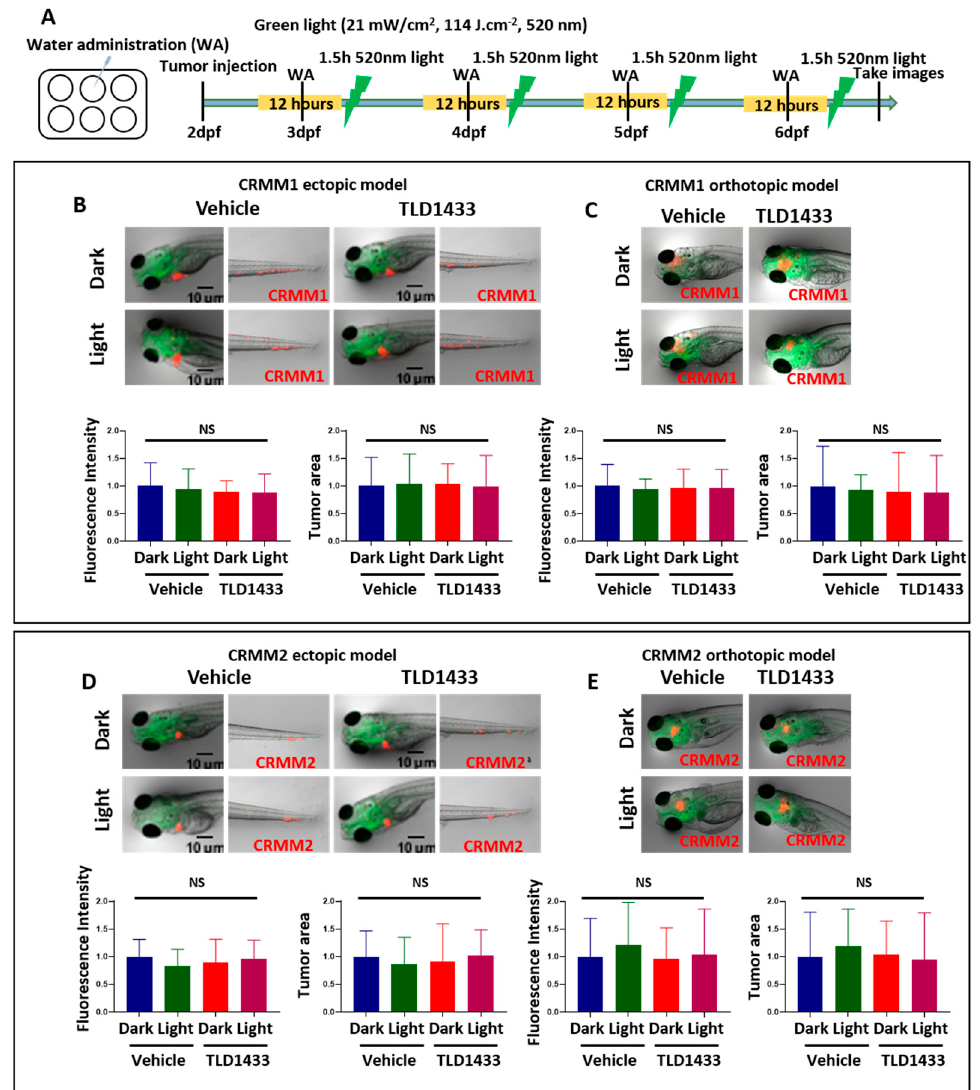
Figure 7. Treatment of zebrafish ectopic and orthotopic CM models with TLD1433 through WA. ( A ) Schedule of tumour injection and TLD1433 administration in zebrafish embryos. Fluorescent CRMM1 and CRMM2 cells were injected at 2 dpf into the Duct of Cuvier (ectopic model) and behind the eye (orthotopic model) and TLD1433 was administered with or without a light treatment following the schedule presented in A. Relative tumour burden estimated as fluorescence intensity and tumour area was calculated by Image J. ( B ) CRMM1 tumour burden in ectopic model ( n ≈ 30). ( C ) CRMM1 tumour burden in orthotopic model ( n ≈ 15). (D) CRMM2 tumour burden in ectopic model ( n ≈ 30). (E) CRMM2 tumour burden in orthotopic model ( n ≈ 15). Results are presented as means ± SD from three independent experiments. Representative images show CM tumour burden in the head and tail regions in the ectopic model and a localised tumour in the orthotopic model.